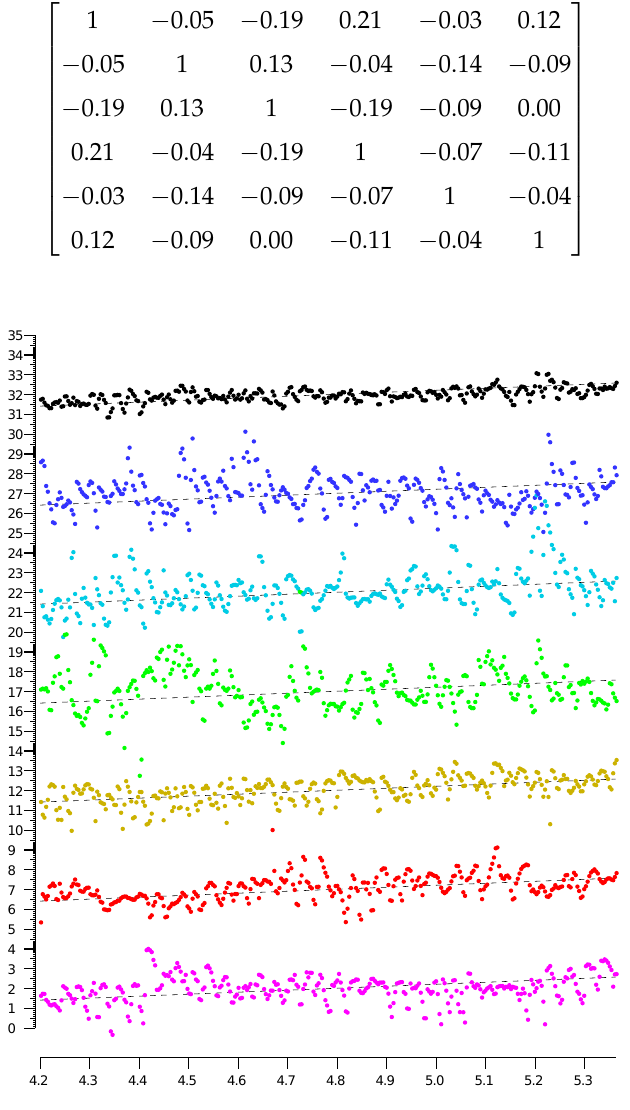
Figure 6. Sample plots (colored) of reported distances in six 80 MHz wide channels in the 5 GHz band. The top (black) plot is a simple average, which has less than half the error of the individual measurements. Horizontal axis: actual distance in meters. Vertical axis: reported distance in meters. (Note that the average slope of the plots is not equal to one, because the scales on the vertical axis and horizontal axes are different). (Individual plots are offset vertically to avoid